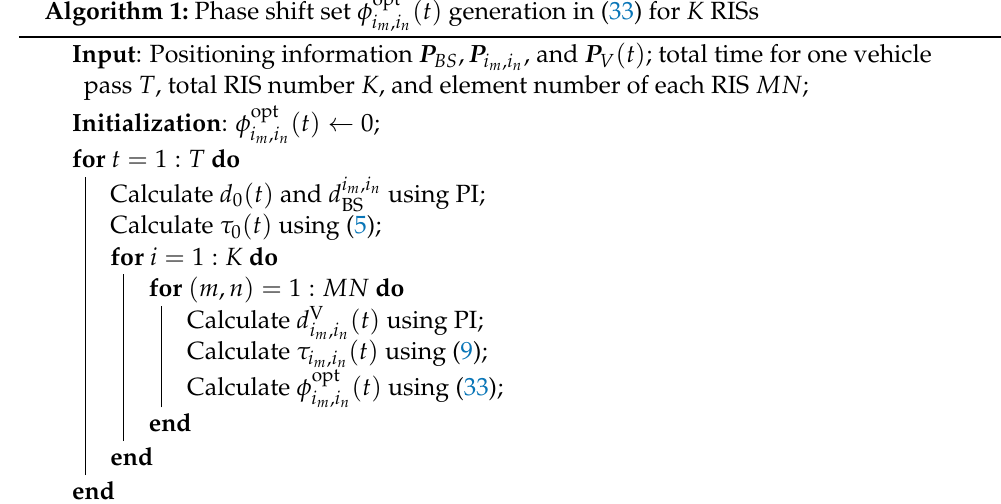
( t ) generation in (33) for K i m , i n